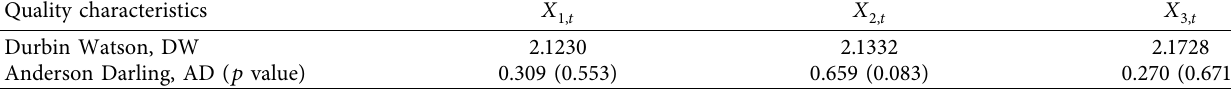
Table 3: Statistical test results to determine i.i.n.d. of logarithmic return for data X